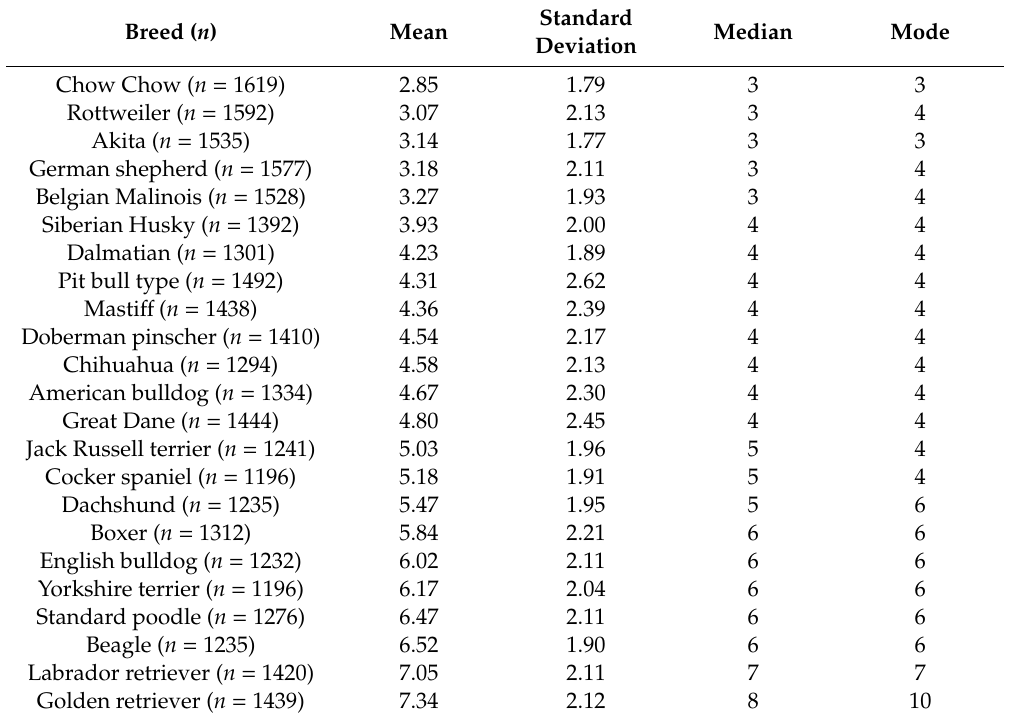
Table 8. Mean, median, and mode scores given by veterinarians to rate their emotional response to being approached by an unfamiliar adult dog o ff -leash from a list of 23 common U.S. dog breeds. (0 = petrified and 10 = deliriously happy / excited).